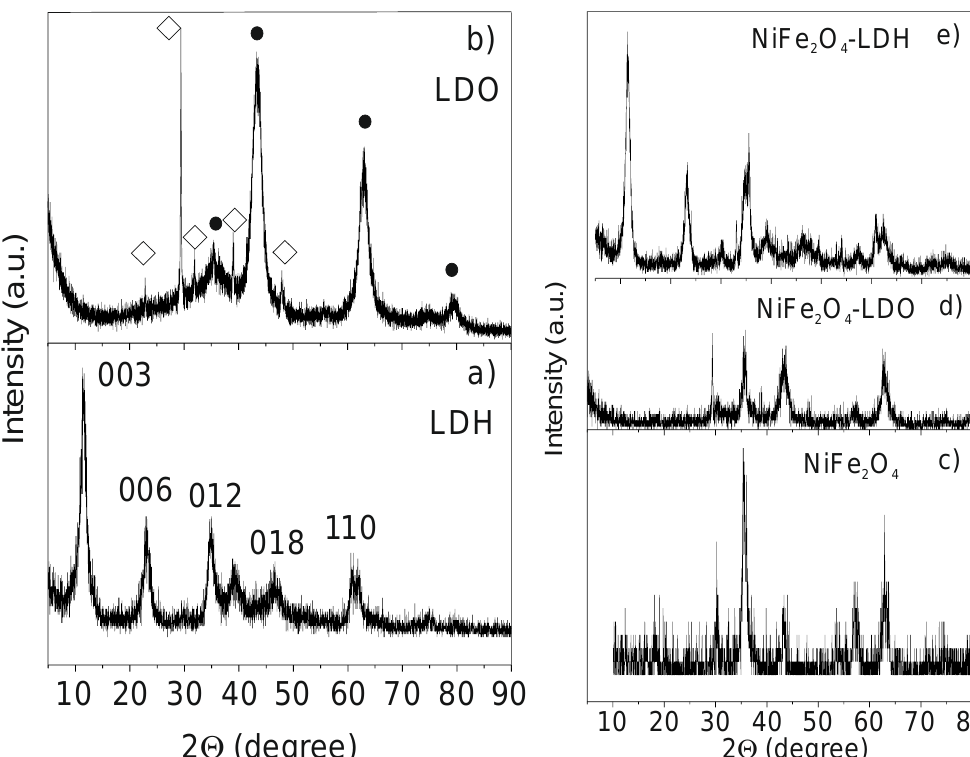
Figure 1. X-ray diffraction (XRD) patterns of: ( a ) as-prepared layered double hydroxide (LDH); ( b ) layered double oxides (LDO) mixture obtained after calcination of LDH; ( c ) as-prepared NiFe 2 O 4 NPs; ( d ) NiFe 2 O 4 -LDO composite before adsorption; and, ( e ) NiFe 2 O 4 -LDH composite obtained after the methyl orange (MO) degradation.